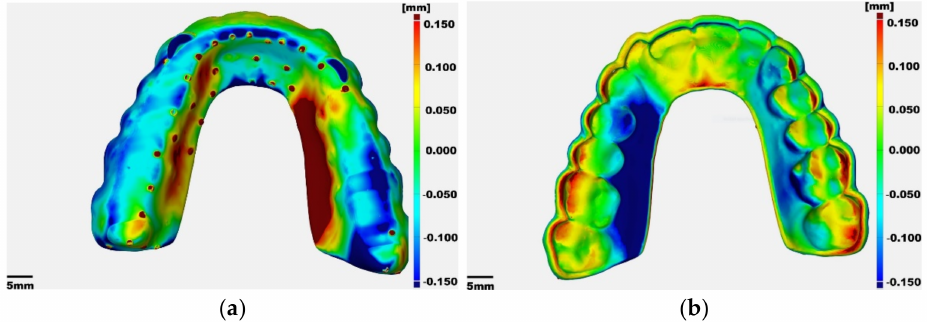
Figure 3. Representative example of the surface deviations of [4.5_TOTAL] (Scale ± 150 µ m) from the reference data file with respect to the; ( a ) external surface; ( b ) internal